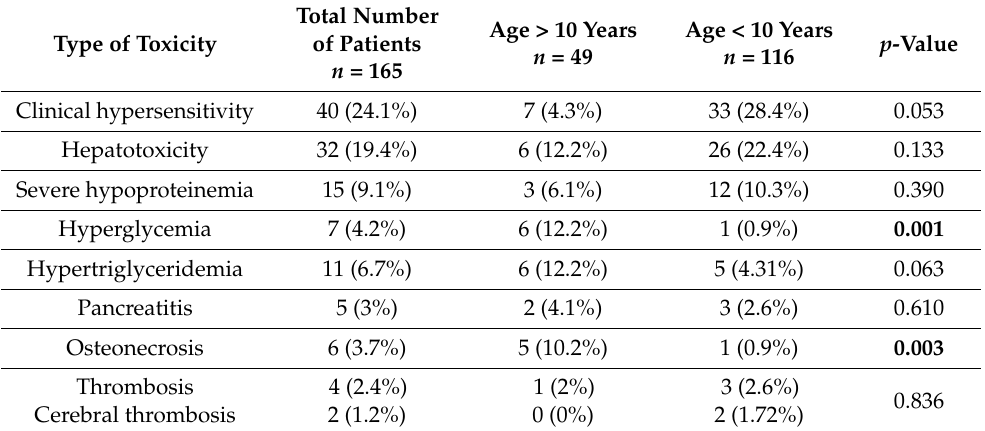
Table 1. Incidence of L-asparaginase-associated